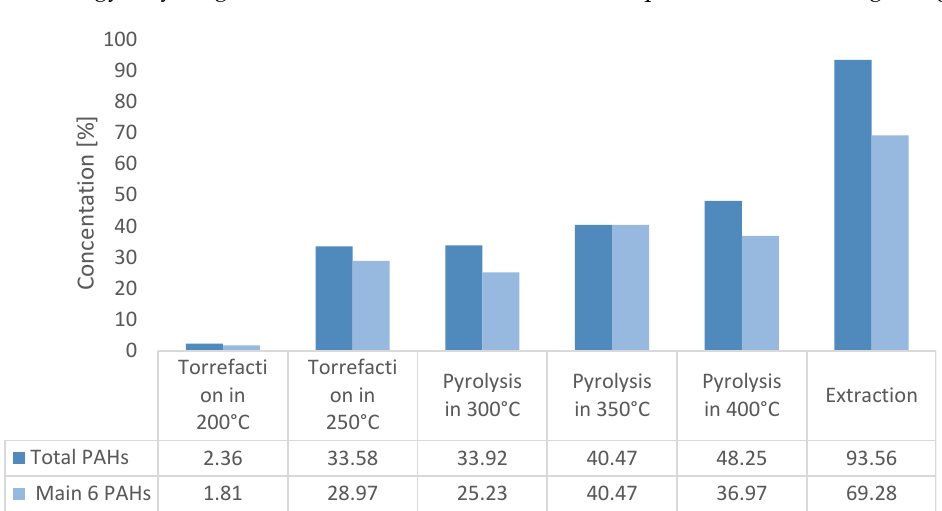
Figure 7. Extracts from the obtained chars ( left ) and pyrolytic oil ( right ).